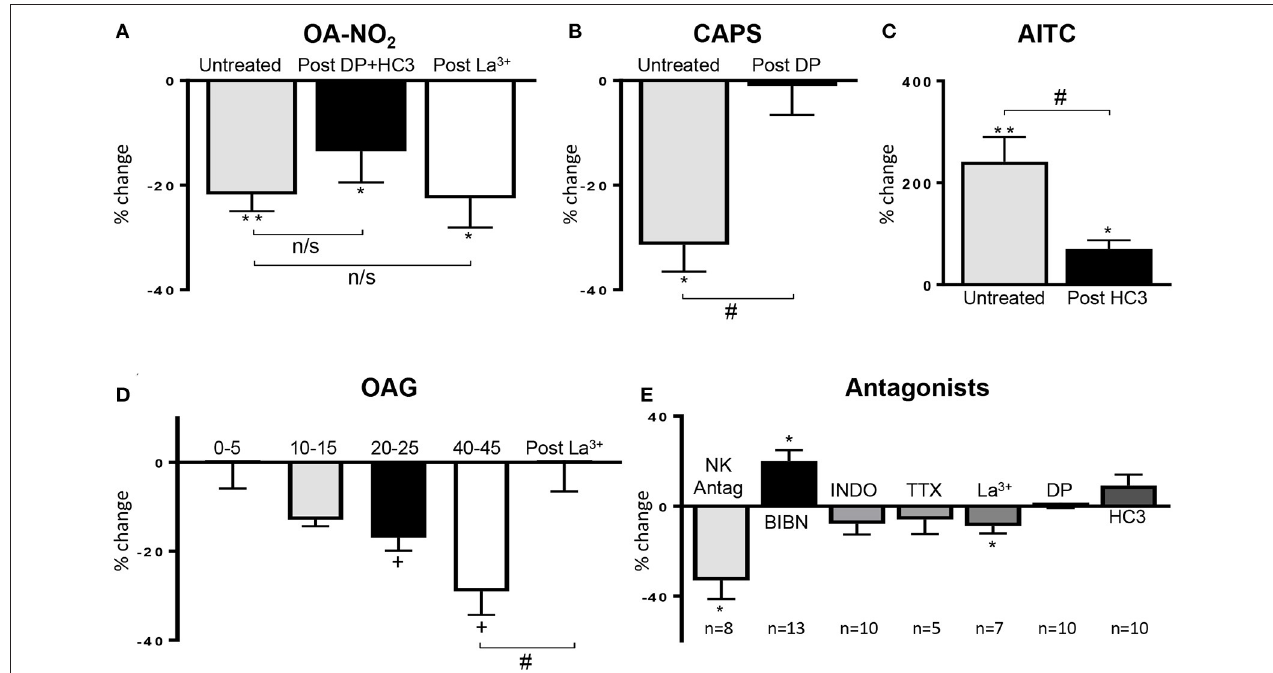
FIGURE 3 | (A) Summary data showing that the OA-NO 2 inhibitory response is not blocked by a combination of a TRPV1 (diarylpiperazine, DP) and a TRPA1 antagonist (HC3; n = 16) or the TRPC antagonist (La 3 + , 50 µ M; n = 9). (B,C) Summary data showing that DP and HC3 suppress the effects of CAPS ( n = 12) and AITC ( n = 16), respectively. (D) Summary data showing the time course of the inhibitory effect of OAG ( n = 10–12) and the block of this effect by La 3 + (50 µ M; n = 6), 45min after application of OAG. (E) Effect of various antagonists on SBC AUC shown as % change from control SBC activity before treatment. Neurokinin receptor antagonists (NK Antag), a combination of three antagonists subtypes (1, 2 and 3: SR 140333, SR 48968 and SR 142801, respectively, 1 µ M of each drug); BIBN (25 µ M, CGRP receptor antagonist), indomethacin (INDO, 500nM, COX inhibitor), concentrations of TTX, La 3 + , DP, and HC3 are the same as those indicated in Figure 2 . Data was obtained from single experiments with either a pristine agonist or an antagonist followed by an agonist and graphs are presented as % change in SBC area under the curve (AUC) compared to basal activity. Statistics were performed on raw numbers: (A–C) 2-tailed t -test, * P < 0.05 and ** P < 0.001, and a two-way ANOVA with Bonferroni multiple comparisons post-hoc tests (brackets), # P < 0.05; (D) one-way ANOVA with Dunnett’s multiple comparison post-hoc test (OAG; + P < 0.05) and two-way ANOVA (bracket) with Bonferroni multiple comparisons post-hoc test (La 3 + ; # P < 0.05); (E) 2-tailed t -test, * P < 0.05, compared with basal activity; n , number of